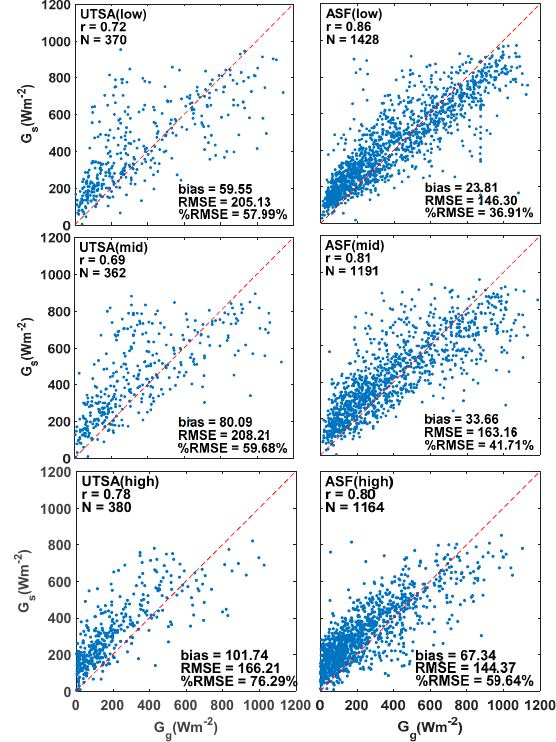
Figure 6. Scatter plots showing the correlation of G s versus G g for the three cloud layers (low, mid, and high) at UTSA ( left panel ) and ASF ( right panel ).